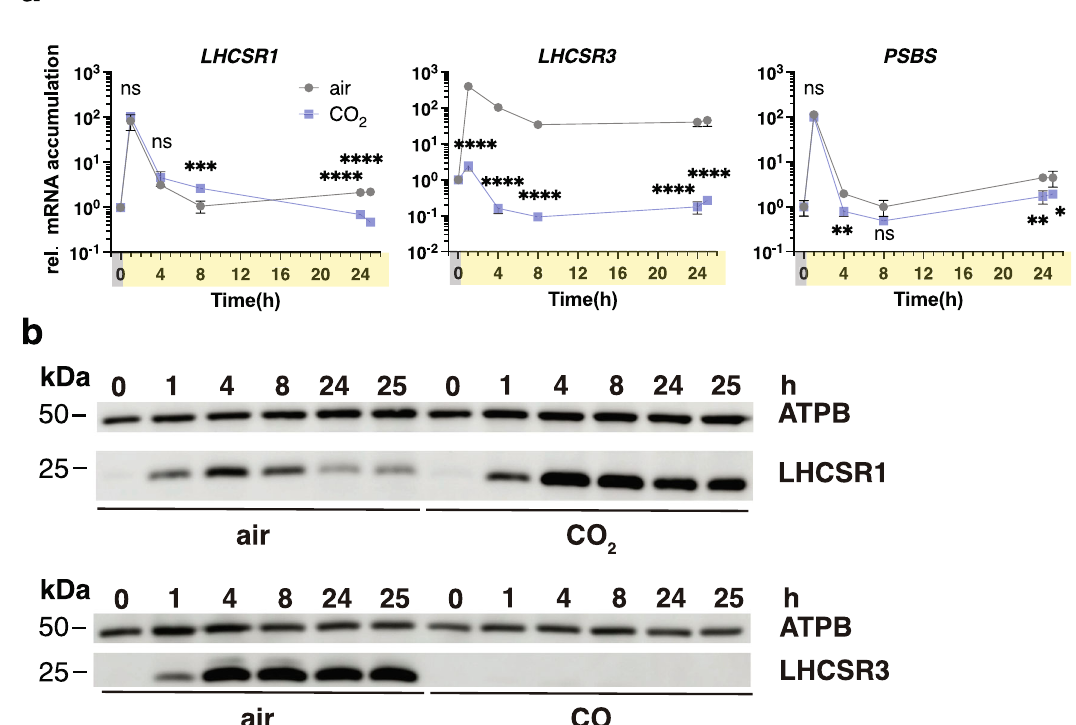
Fig. 4 | Kinetic resolution of photoprotective gene and protein expression at different light and CO 2 availabilities. Cells were acclimated overnight at LL (15 µ molphotonsm − 2 s − 1 )bubbledwithair(labelled “ air ” ).Att=0thelightintensitywas raisedto600 µ molphotonsm − 2 s − 1 underairbubblingorbubblingwith5%CO 2 and mRNA and protein were followed for 25h. a LHCSR1, LHCSR3 and PSBS mRNA accumulation. ( n =3 biological samples, mean ± s.d.). The p-values for the